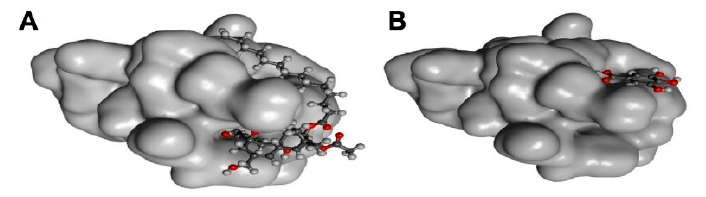
Figure 4. MCDA of binding interactions of PKC δ . Phorbol ester ( A ) and gallic acid ( B ) bind to the similar sites in PKC δ . Reproduced from [25] under the terms of the Creative Commons Attribution-NonCommercial-ShareAlike